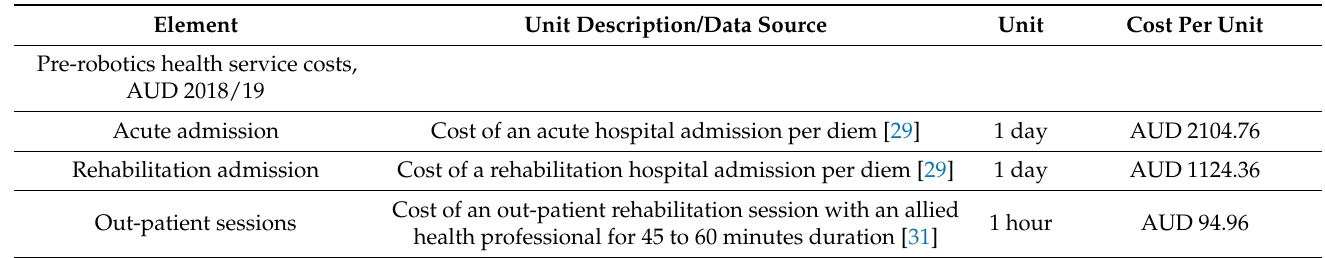
Table 2. Cost data—units of measure for health care